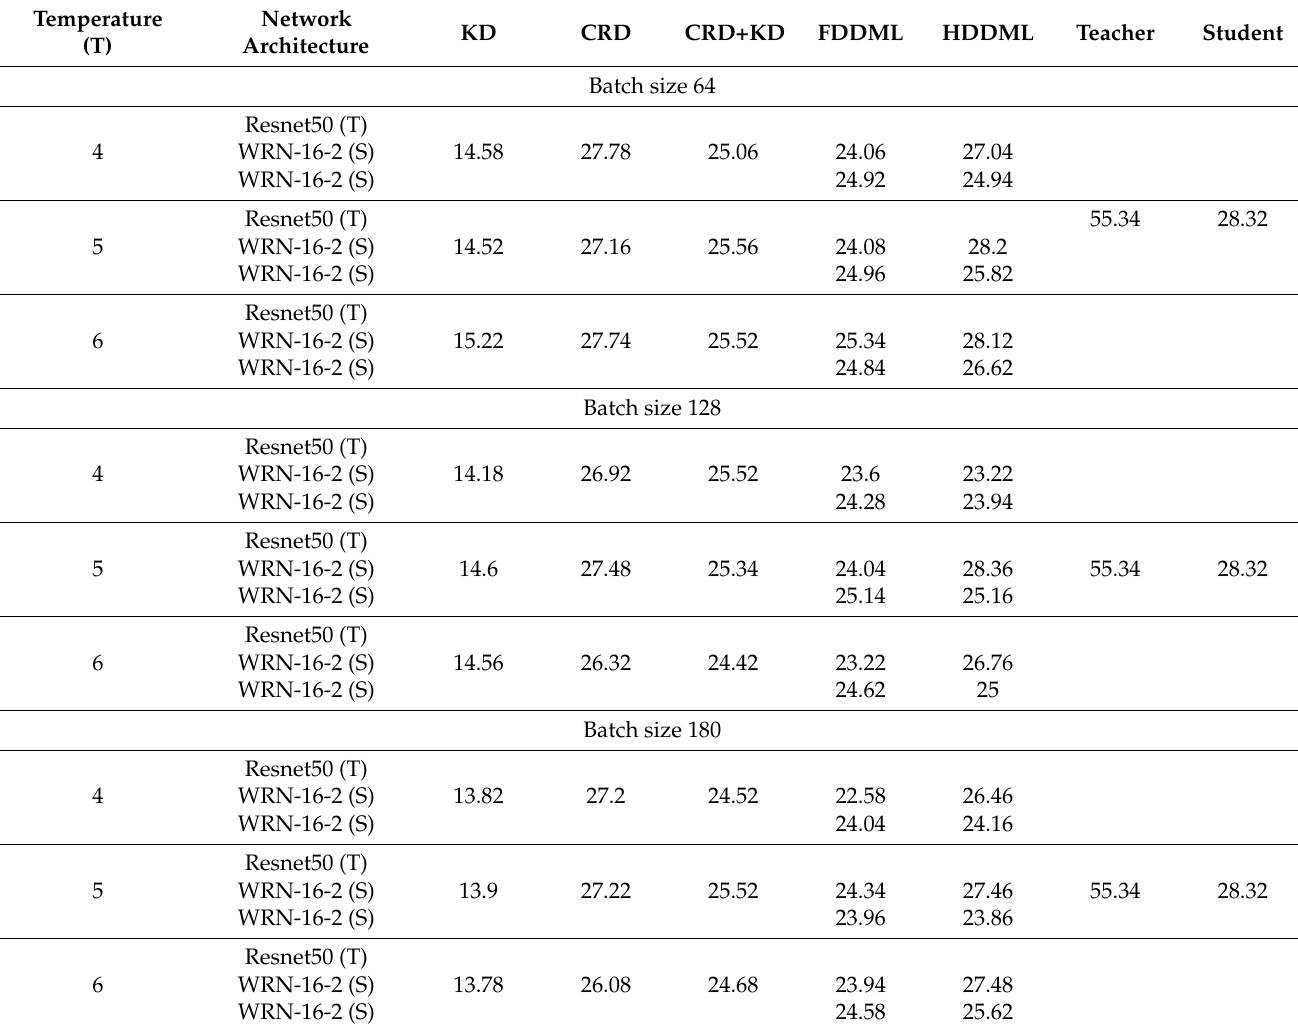
Table 6. Knowledge transfer from original images sample 64 × 64 model teacher pre-trained to train student with images downsampled to 32 × 32 using TinyImageNet